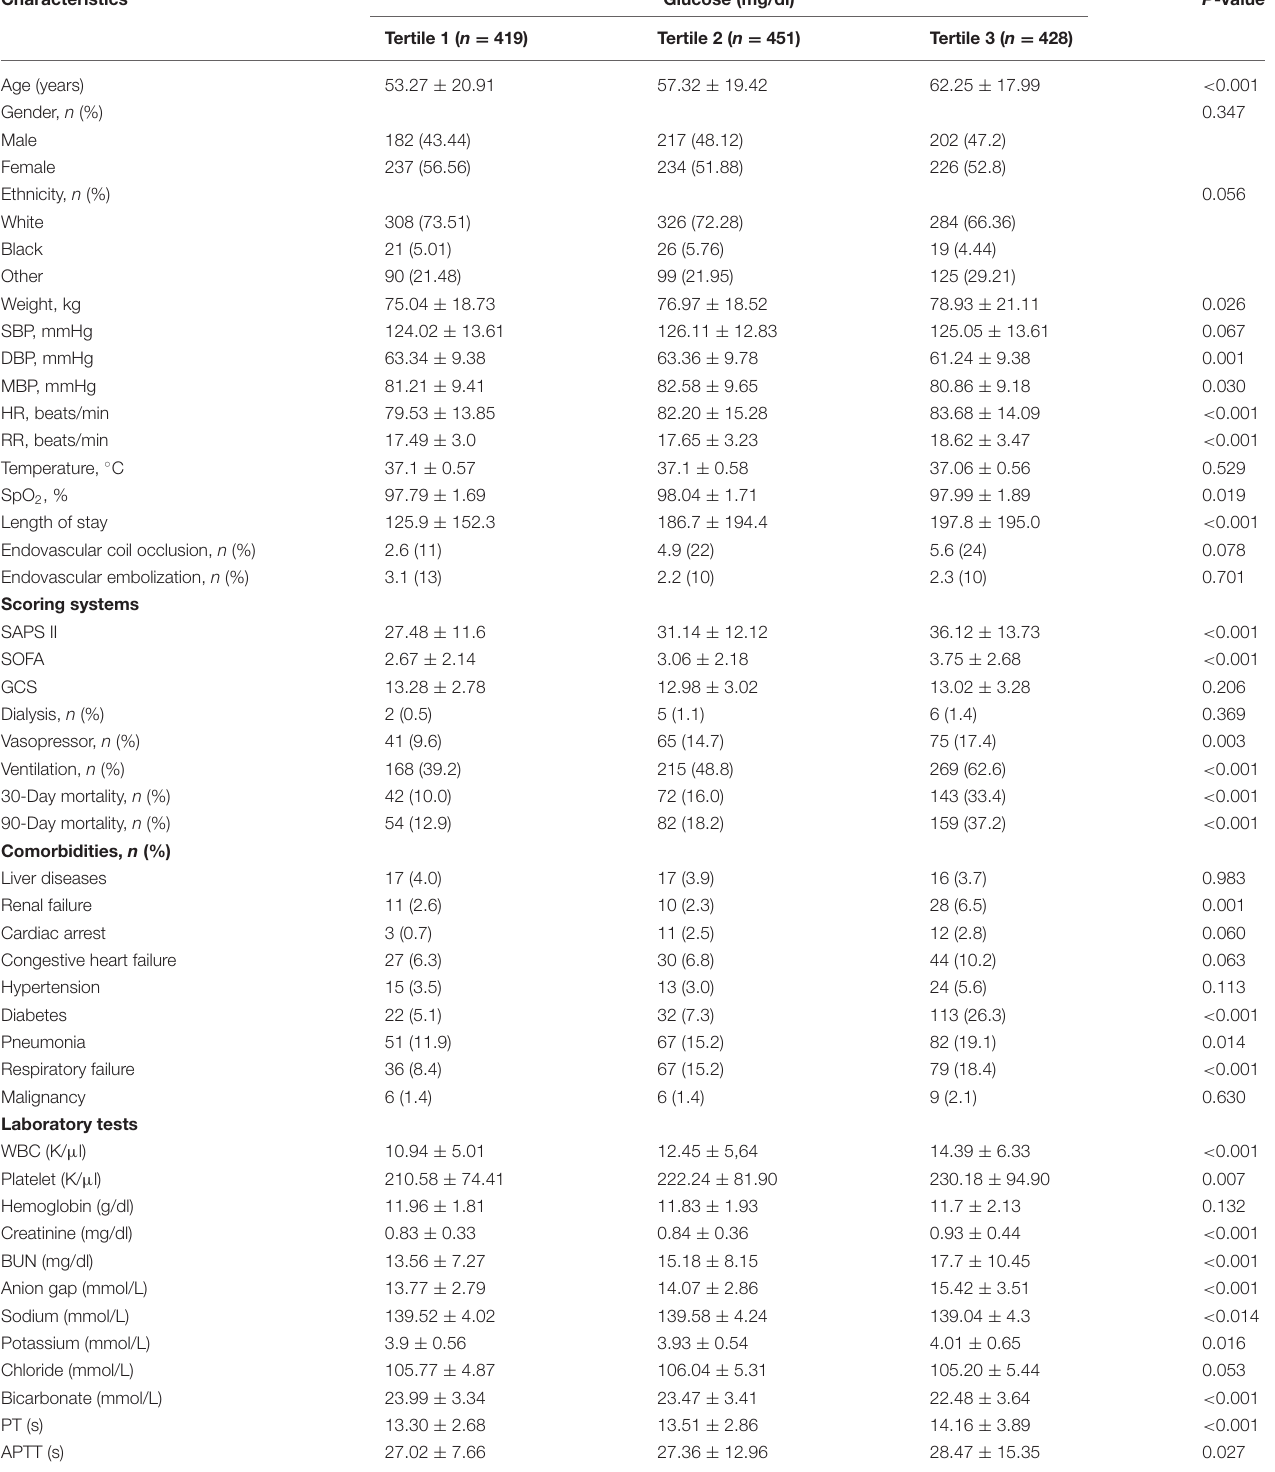
TABLE 1 | The clinical characteristics of critically ill patients with subarachnoid hemorrhage based on admission blood glucose tertile.